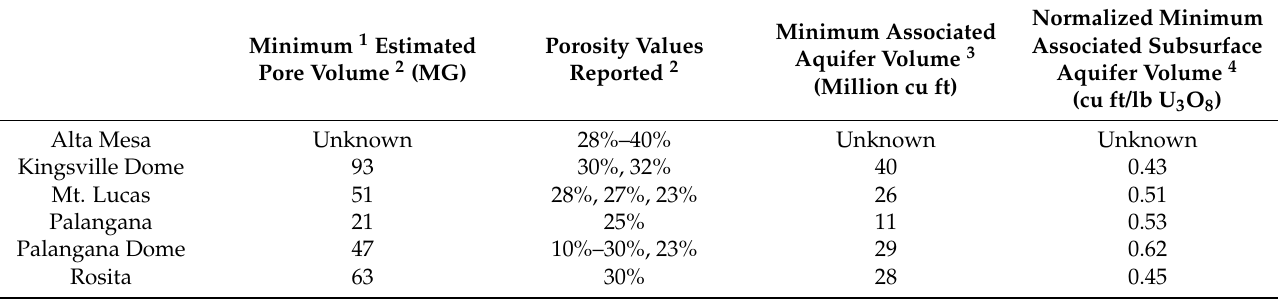
Table A4. Minimum volume of potentially affected aquifer for ISR operations completed in the Goliad